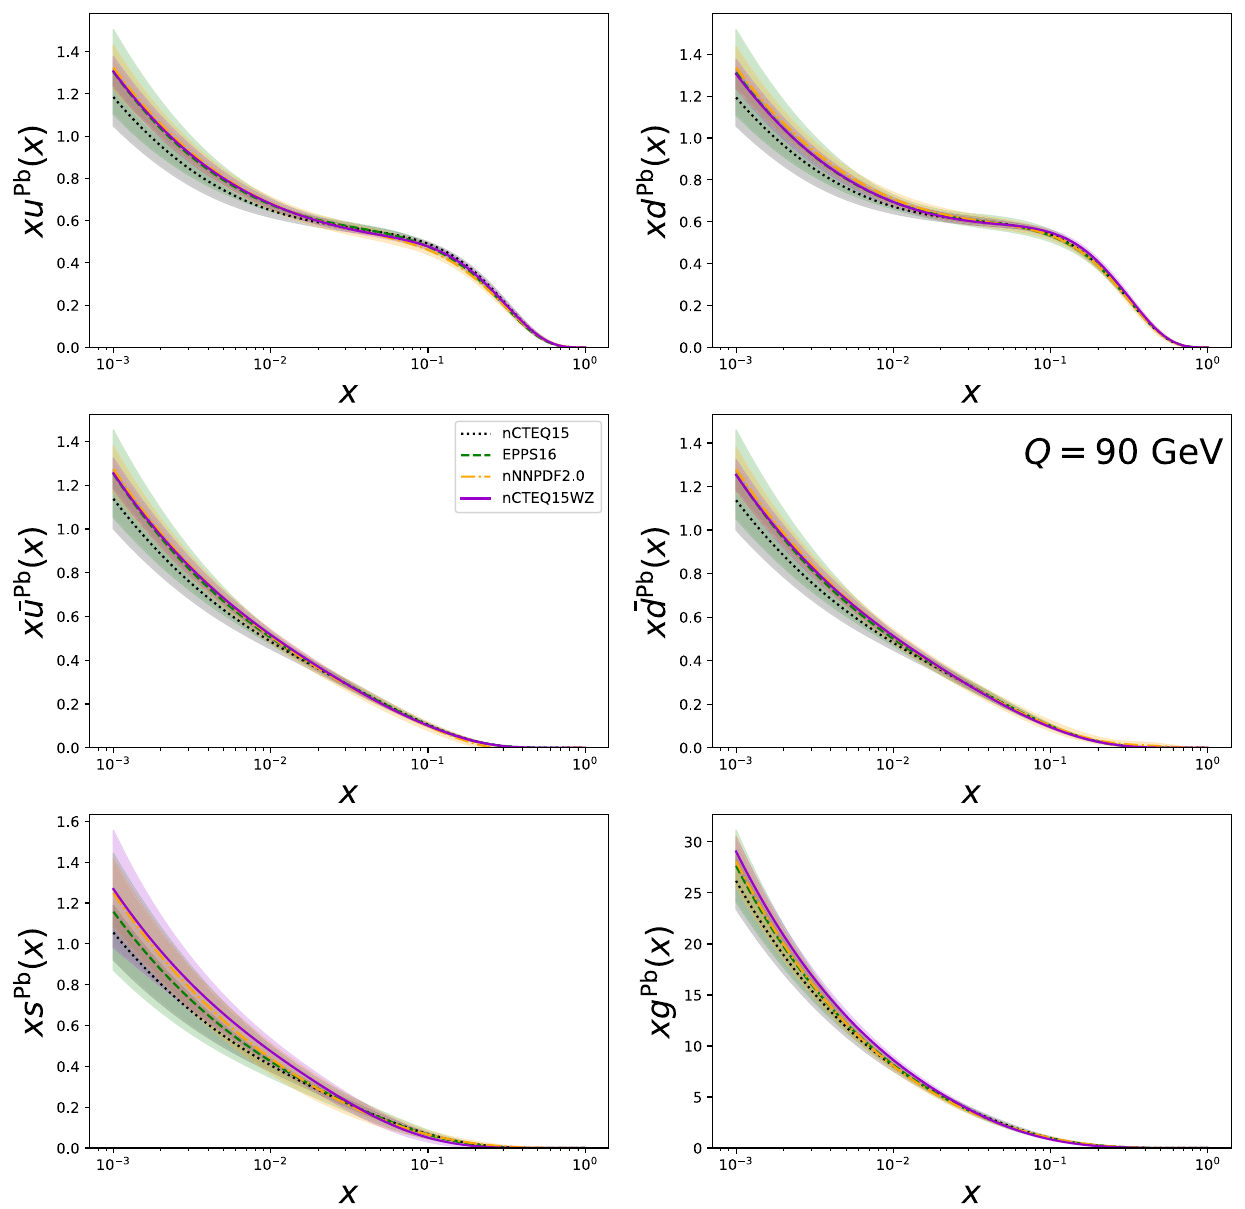
Fig. 13 Comparison of the full lead (Pb) PDFs at Q = 90GeV for nCTEQ15, EPPS16, nNNPDF2.0 and nCTEQ15WZ. The uncertainty band for nCTEQ15 is shown in gray, nCTEQ15WZ in violet, nNNPDF2.0 in yellow and EPPS16 in